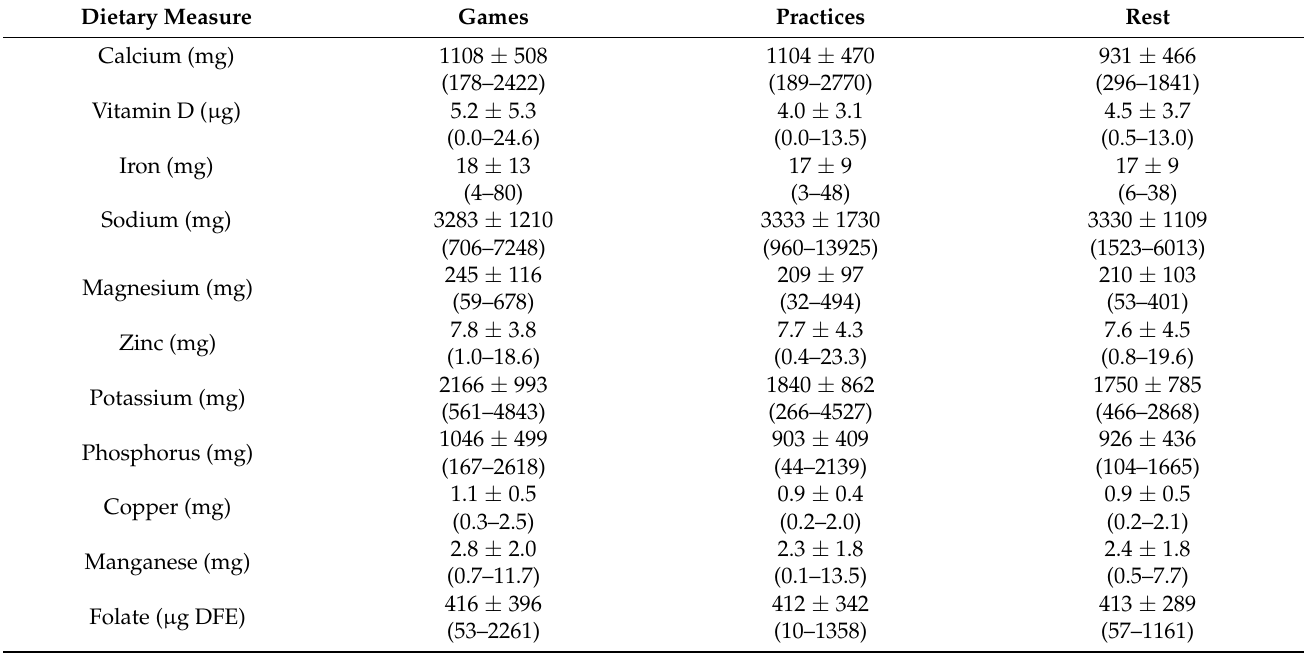
Table 4. Selected micronutrient intakes for game, practice, and rest days in varsity female ice hockey players.